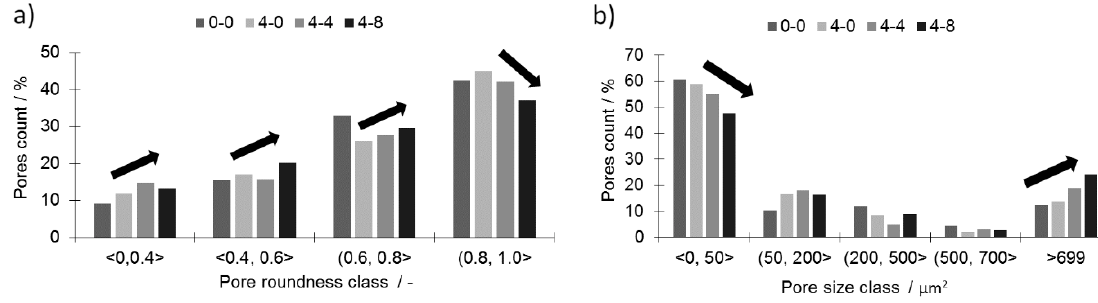
Figure 5. Histograms of the pores: ( a ) roundness; ( b ) area.